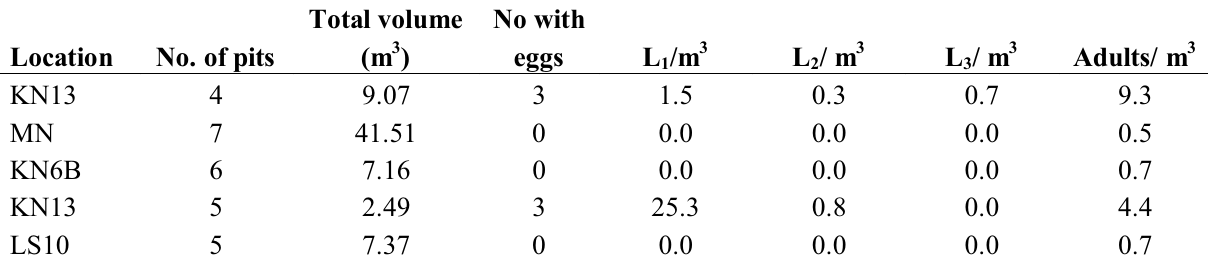
Table 7. Summarized results of sampling for Cochliotis melolonthoides and